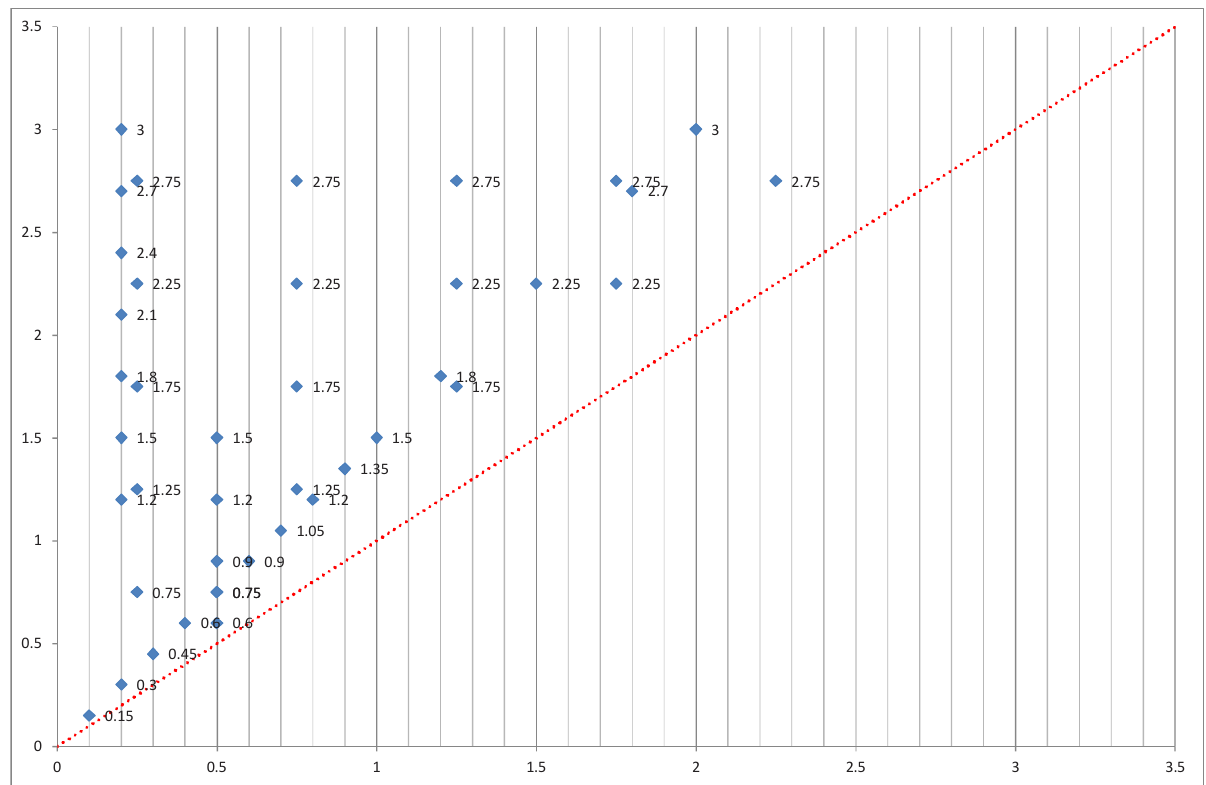
Figure 7. Simulation designs: 40 pairs of markup